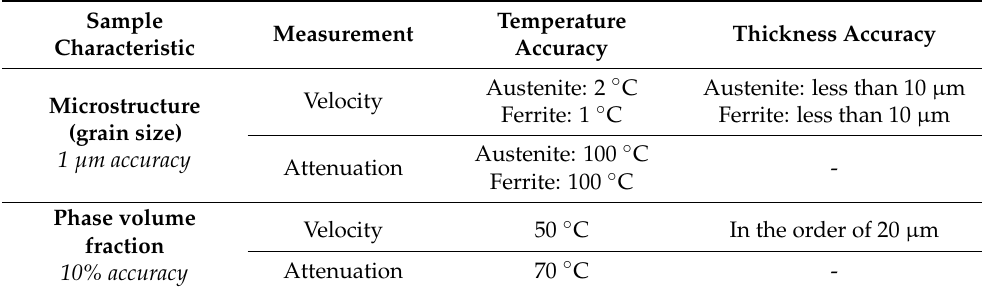
Table 4. An overview of the cross-dependencies of temperature and thickness